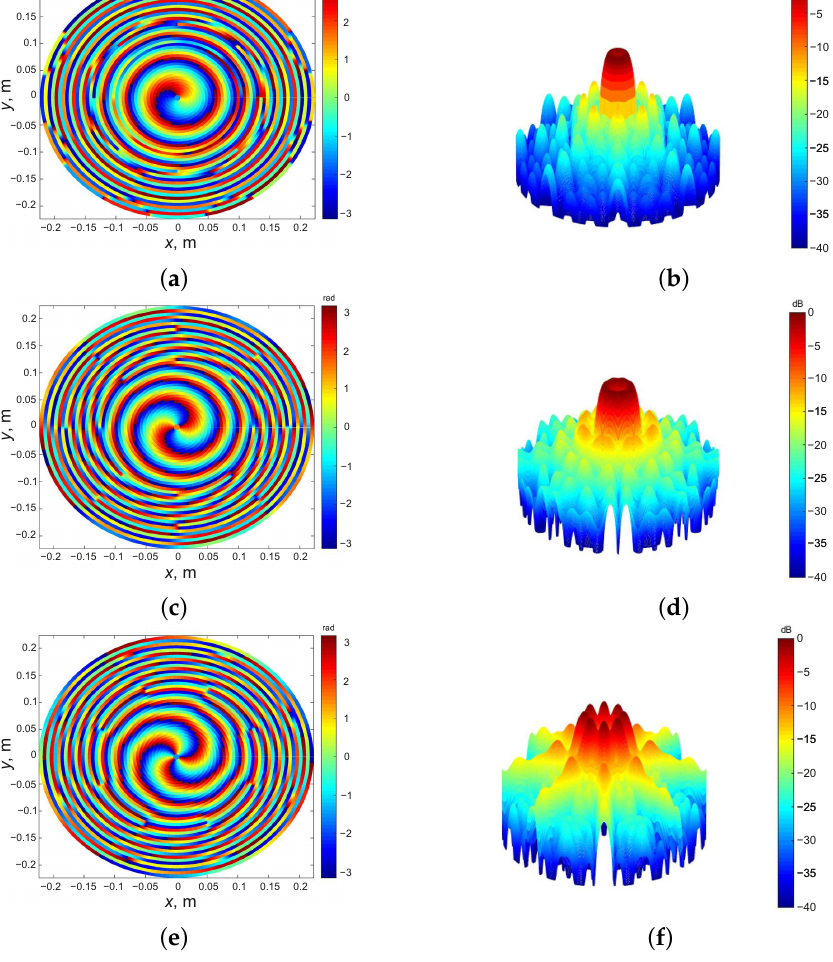
Figure 2. Phase-front distributions and radiation patterns of different OAM modes l = +1 ( a , b ); l = +2 ( c , d ); l = +3 ( e , f ) formed by lens with N =